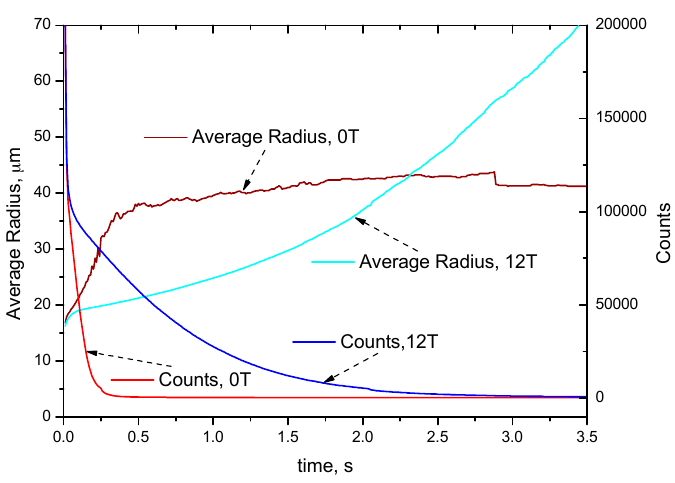
Figure 4. Average radius and number of droplets as a function of time.